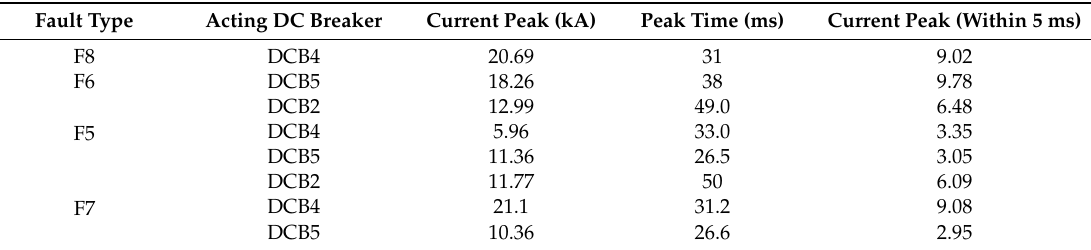
Table 10. Fault current calculation result of each DC